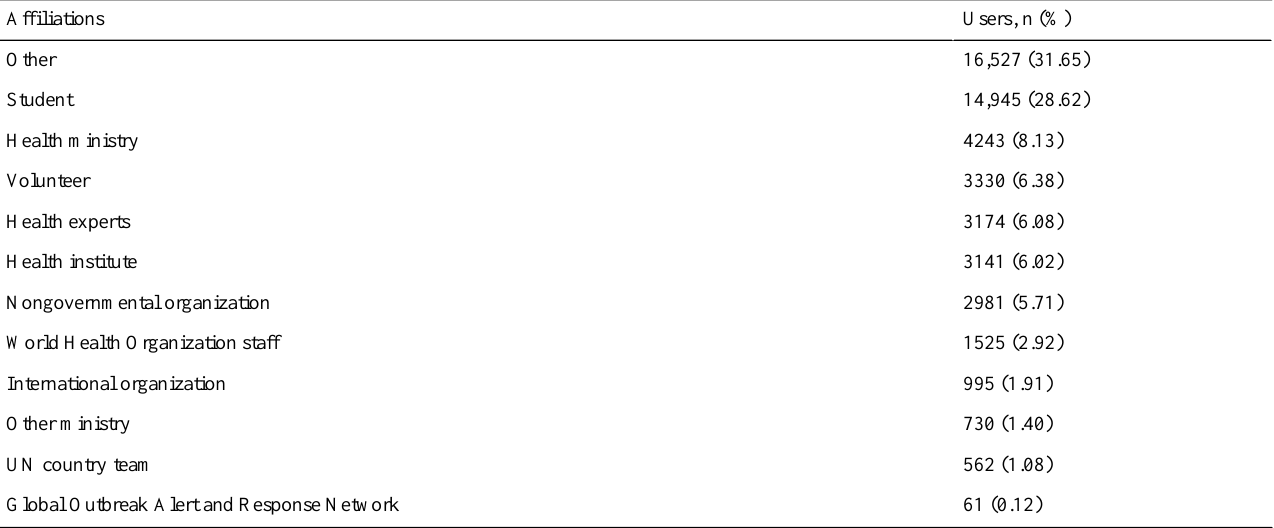
Table 2. Users’professional affiliations for the total users who specified their professional affiliation (n=52,214).